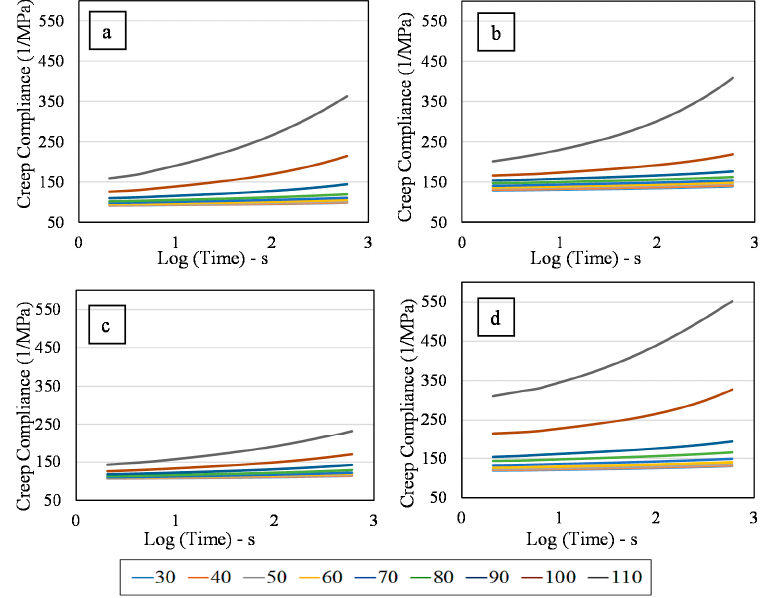
Figure 7. Creep Compliance of ( a ) Unt./VE; ( b ) Unt./VE+AR; ( c ) Alkaline/VE; ( d ) Alkaline/VE+AR at different temperatures.